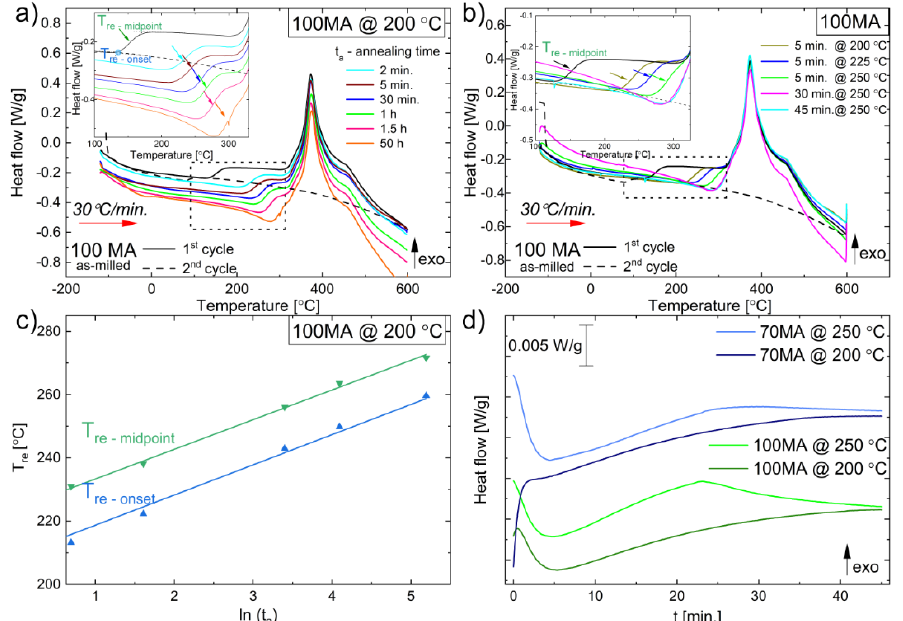
Figure 5. DSC heating curves recorded at 30 °C/min for 100MA as ‐ milled powder and after anneal ‐ ing: ( a ) at 200 °C for 2 min, 5 min, 30 min, 1 h, 1.5 h, 50 h; ( b ) for 5 min at 200 °C, 225°C, and 250 °C and for 30 min, 45 min. Insets-magnified regions marked by dashed rectangular. Relaxation temperatures T re (T re–onset , T re–midpoint ) pointed out by coloured arrows. ( c ) plot of T re vs. ln(t a ), t a —time of annealing at 200 °C; ( d ) isothermal DSC curves at 200 °C and 250 °C for 70MA and 100MA powders.